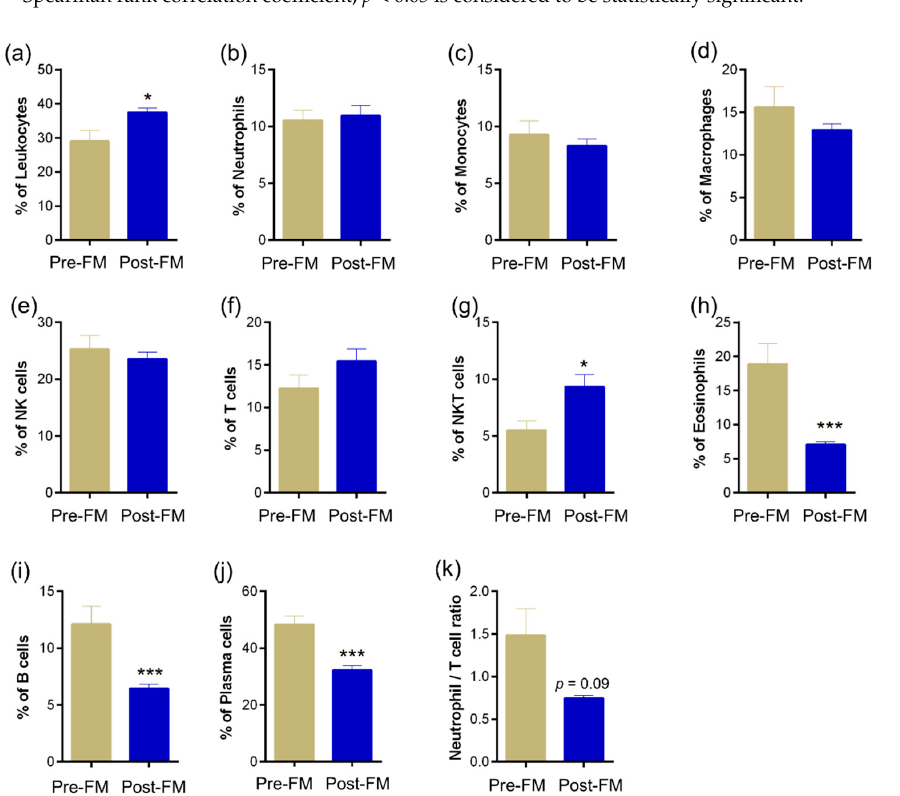
Figure 4. Ocular surface immune cell subset proportions during the face-mask-wearing era. Graph indicates percentage of ( a ) leukocytes—CD45+ cells within the cells analysed in ocular surface wash samples collected from matched study subjects prior to and during the face-mask-wearing era. Graphs indicate the percentages of ( b ) neutrophils—CD45+CD11b+CD16+CD66b+ cells, ( c ) monocytes—CD45+CD14+ cells, ( d ) macrophages—CD45+CD16+ cells, ( e ) natural killer cells—NK